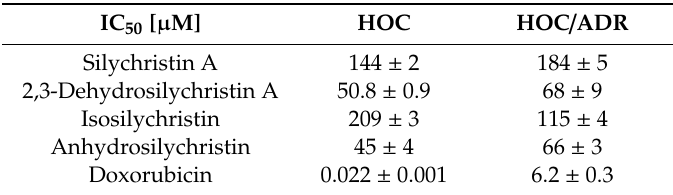
Table 2. Sensitization of doxorubicin-resistant human ovarian adenocarcinoma cell line by silychristin A and its derivatives expressed as